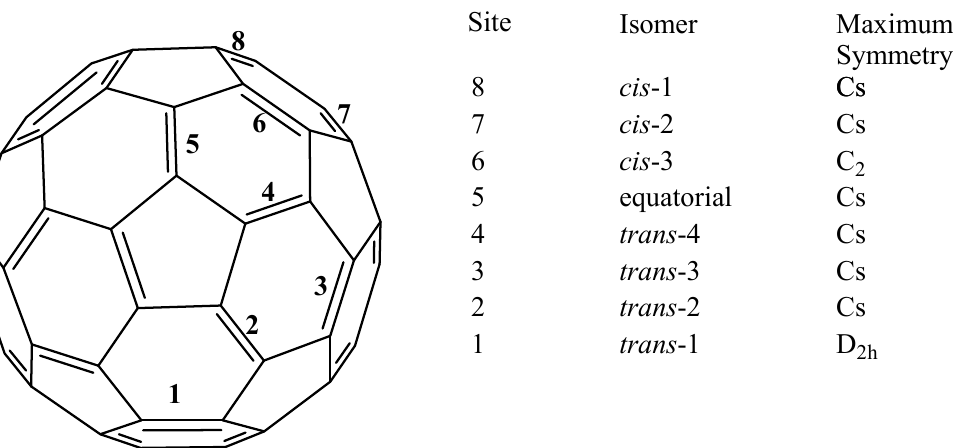
Figure 1. Regiochemistry of double addition to fullerene C